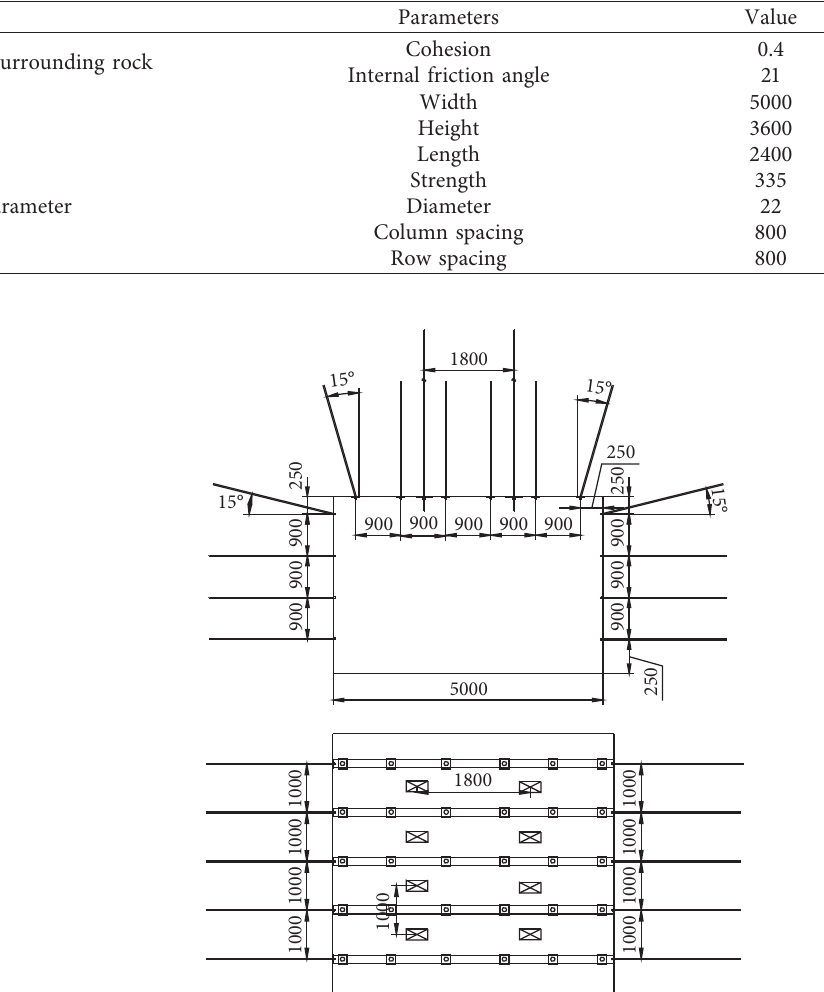
Table 25: Relevant parameters of tailgate N1303.